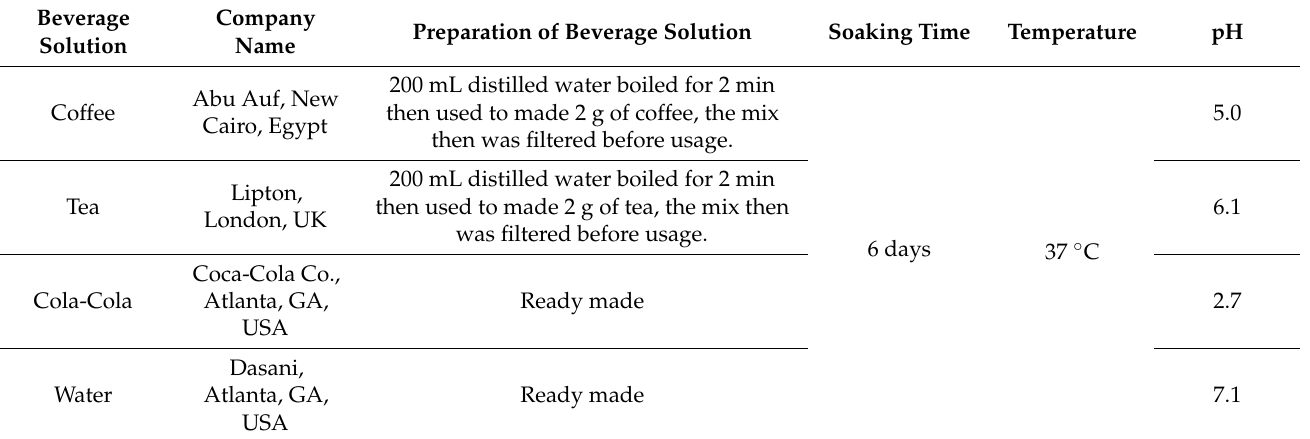
Table 2. Protocol of beverage